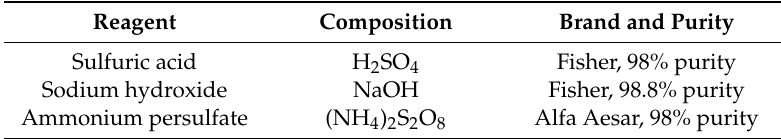
Table 1. Reagents used for the